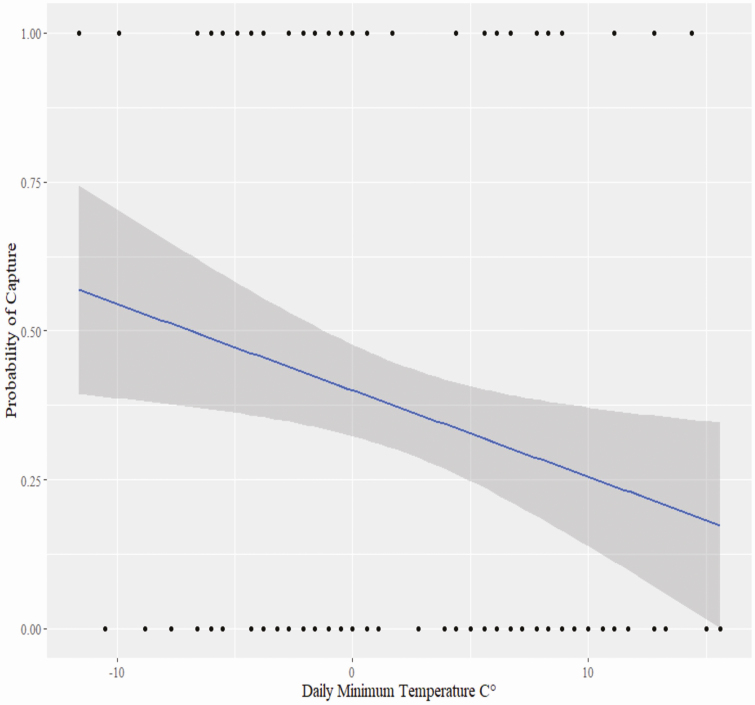
Regression of capture success versus daily minimum temperature (°C) (95% CI [−0.119, −0.013], RMSE = 1.13, P = 0.016).